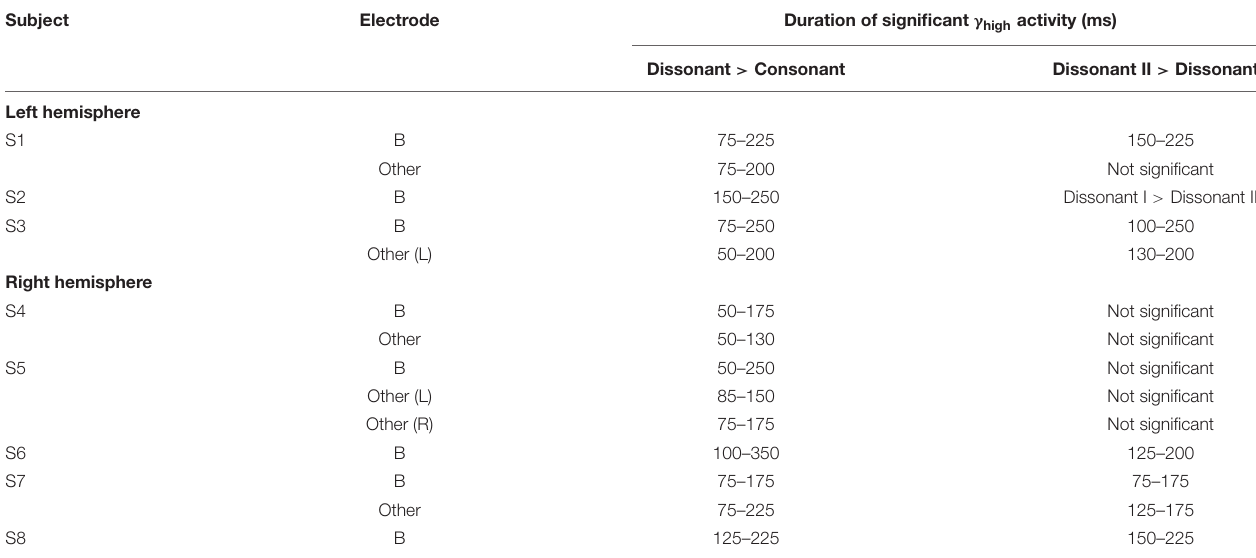
TABLE 2 | Duration of increase in γ high activity for (1) dissonant chords vs. consonant chords and (2) dissonant II chords vs. dissonant I chords for significant STG electrodes denoted in red and marked with a ∗ or # in Figure 2 (Wilcoxon rank-sum with FDR correction of q =